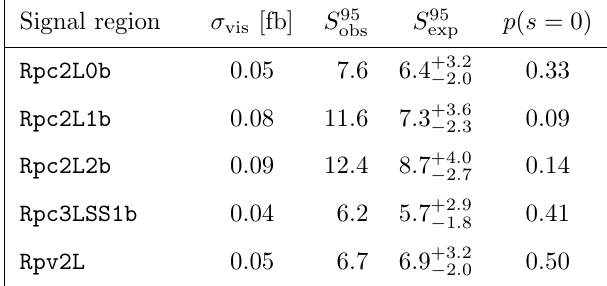
Table 6. Computed 95% CL upper limits on the numbers of BSM events S 95 , as well as the (cid:6) 1 (cid:27) expected (cid:13)uctuations around the mean expected limit. These are also translated into upper limits on the visible cross-section (cid:27) vis . The p -values p ( s = 0) give the probabilities to observe a deviation from the predicted background at least as large as that in the data. They are capped at 0 : 50.